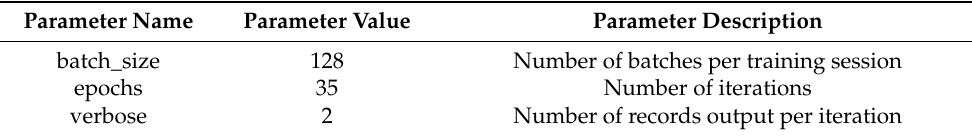
Table 4. Training parameters of the BPNN model.